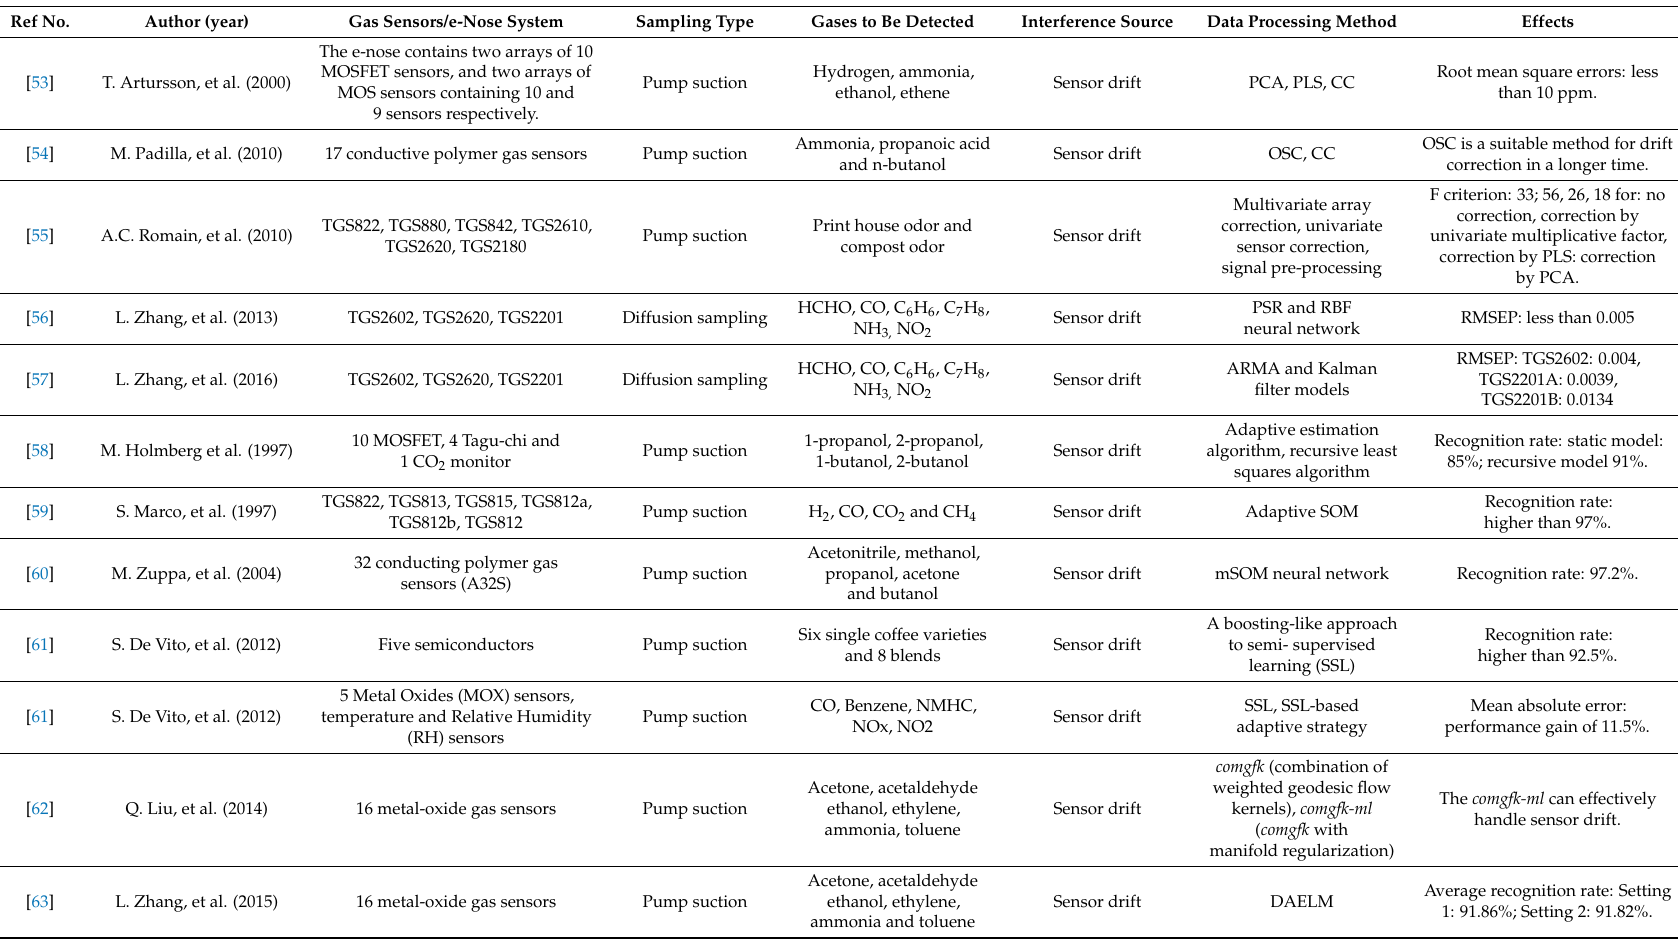
Table 5. Methods for suppressing drift of